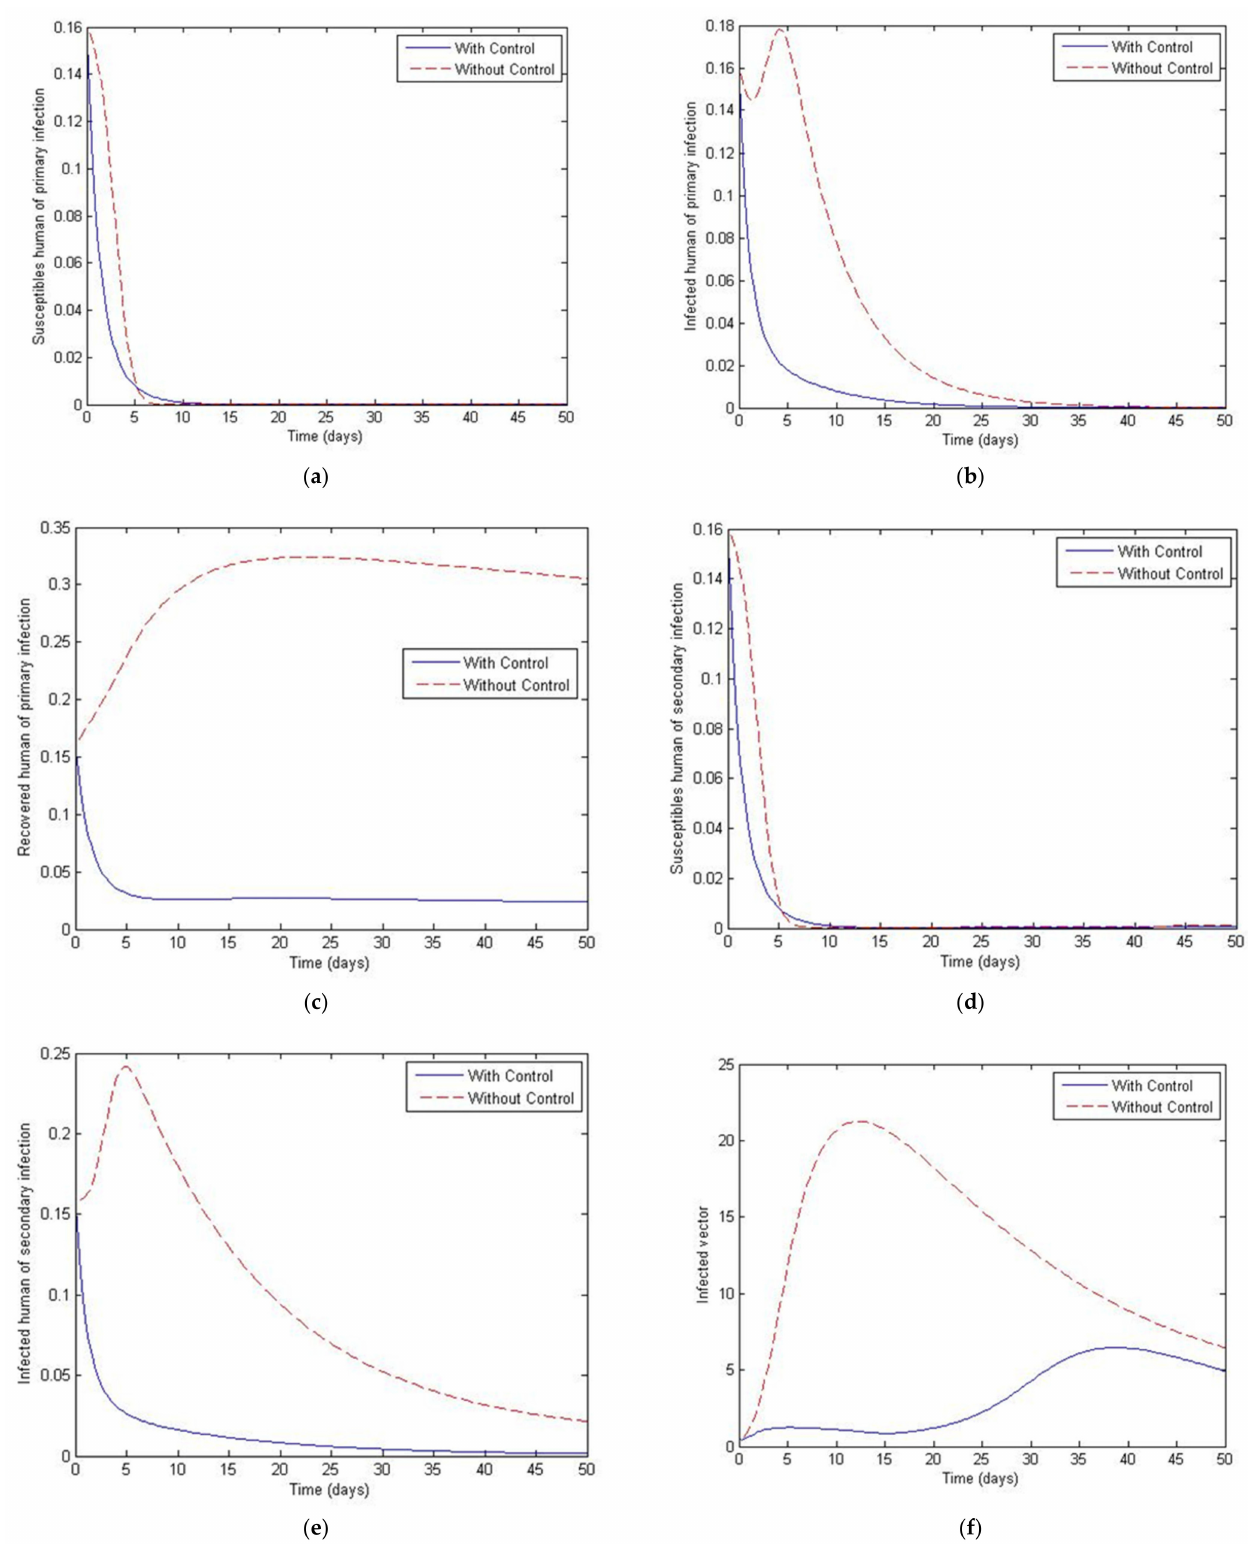
Figure 14. Simulation results of system of Equations (38)–(43) with and without controls of S HP , I HP , R HP , S HS , I HS and I V when X 1 = 100, X 2 = 50. ( a ) Susceptibles of primary infection ( b ) Infected population with primary infection ( c ) Recovered human of primary infection ( d ) Susceptibles of secondary infection ( e ) Infected human of secondary infection ( f ) Infected